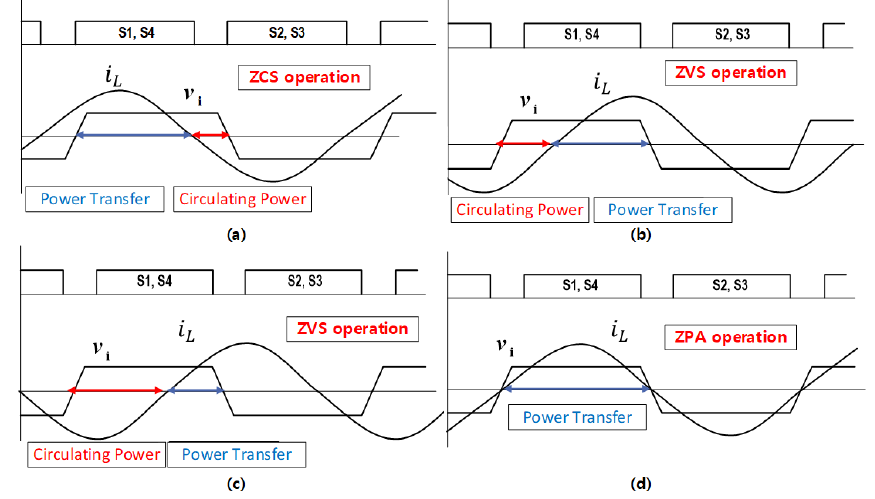
Figure 6. WPT system operation following the switching frequency; ( a ) ZCS operation; ( b ) ZVS operation; ( c ) ZVS operation; ( d ) ZPA operation.